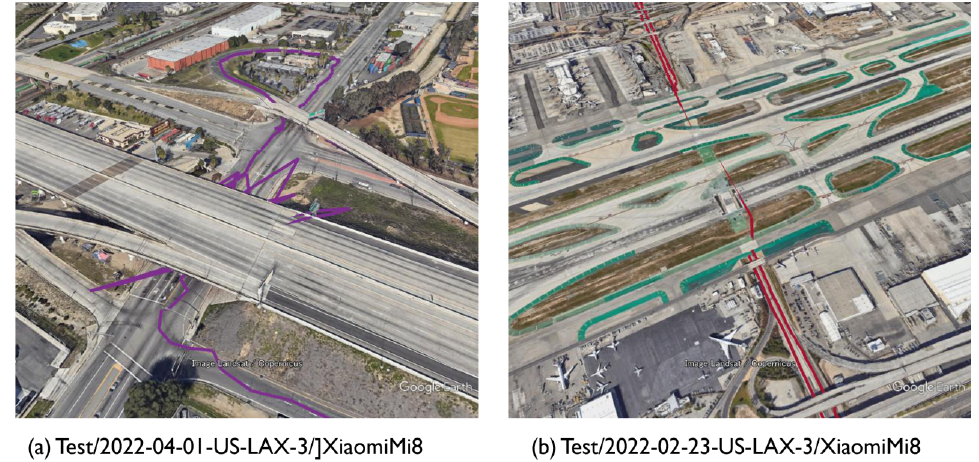
Figure 2. Los Angeles vehicle driving trajectory included in GSDC 2022. ( a ) Stops under elevated tracks and ( b ) runs through long tunnels where GNSS signals are completely